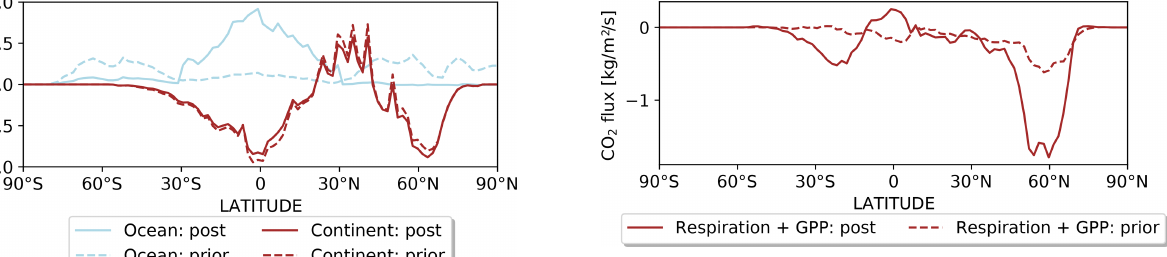
Figure 6. Latitudinal distribution of the prior (dashed line) and pos- terior fluxes (full line) for the continental (brown) and oceanic com- ponents (blue) of the COS budget. The fluxes have been averaged over the years 2009–2019.